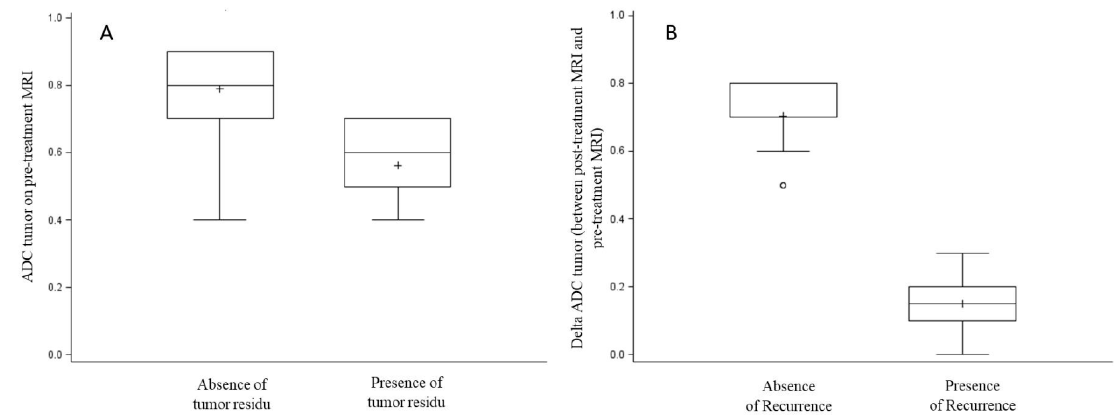
Figure 3. Factors associated with tumor residu ( A ) and early recurrence ( B ). ( A ) Box plot presenting ADC tumor value on pre-treatment MRI according to tumor residu, ( B ) Box plot presenting delta ADC tumor between post-treatment MRI and pre-treatment MRI according to recurrence. Each box shows median (as line), quartiles and mean (as cross). The whiskers represent values below the first quartile and above the third quartile within the 1.5-fold inter-quartile range respectively, and outliers beyond the whiskers are shown as circles.